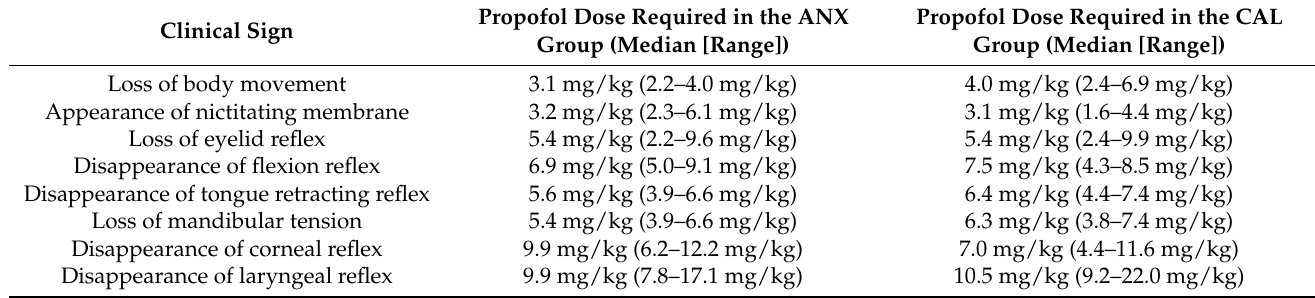
Table 1. Propofol dose required to observe each clinical sign during anesthesia induction.